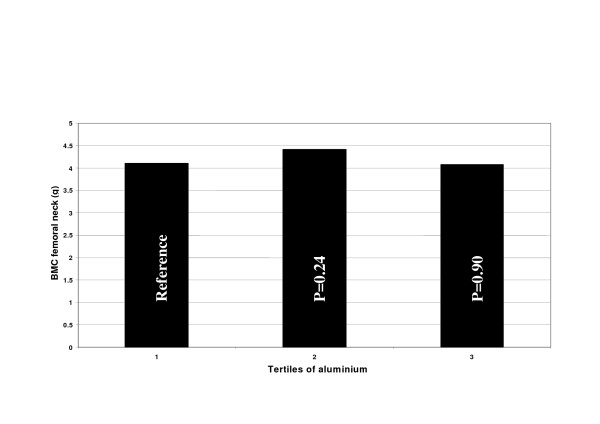
Tertiles Al-BMC. Average adjusted bone-mineral density and content values of the femoral neck by tertiles of aluminium content of bone. Included in the multivariate model were sex, age (by 10-year groups), body-mass index (continuous), height (continuous), creatinine clearance (continuous), demented hip fracture cases (dichotomous) and non-demented hip-fracture cases (dichotomous).